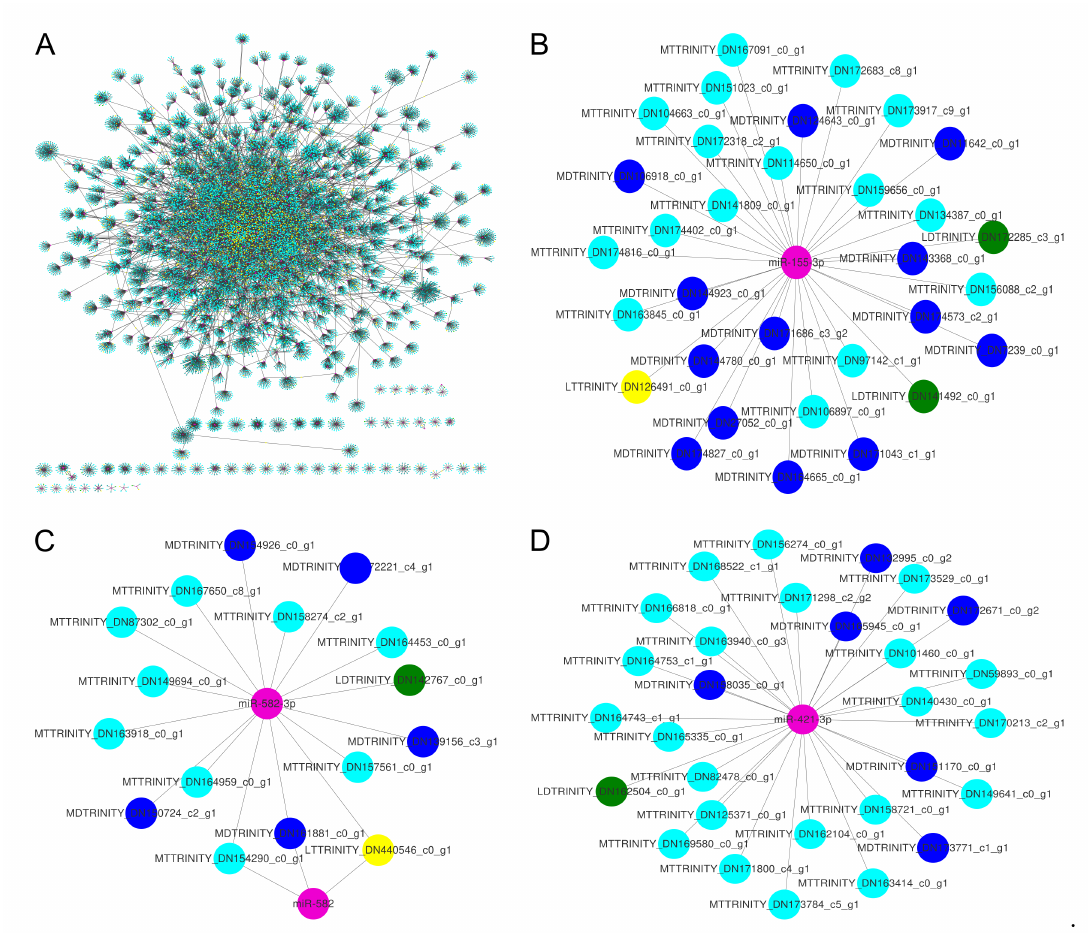
Figure 5. The transcriptome-wide miRNA-regulated networks. pink nodes, miRNAs; yellow nodes, lncRNAs that may be miRNA targets; green nodes, lncRNAs that may be miRNA target mimics; cyan nodes, mRNAs that may be miRNA targets; blue nodes, mRNAs that may be miRNA target mimics; grey edges, correlations. The labels of nodes were prefixed with specific abbreviations, such as MT for mRNA target, LT for lncRNA target, MD for mRNA mimics, and LD for lncRNA mimics. ( B – D ) were extracted from ( A